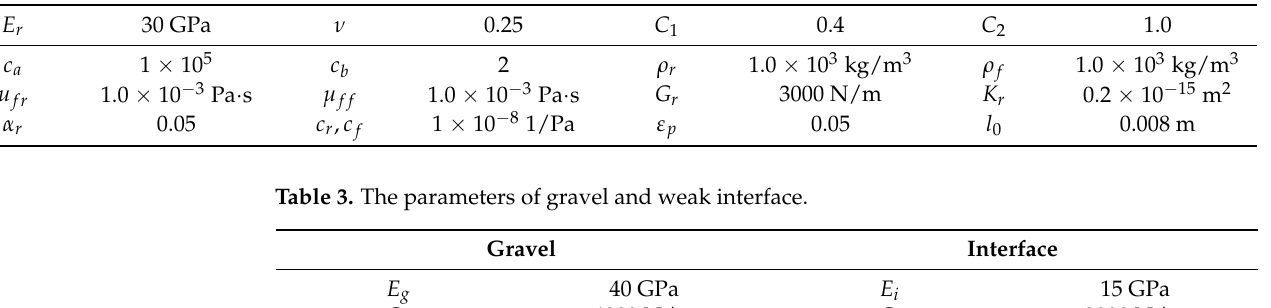
Table 2. The reservoir parameters.